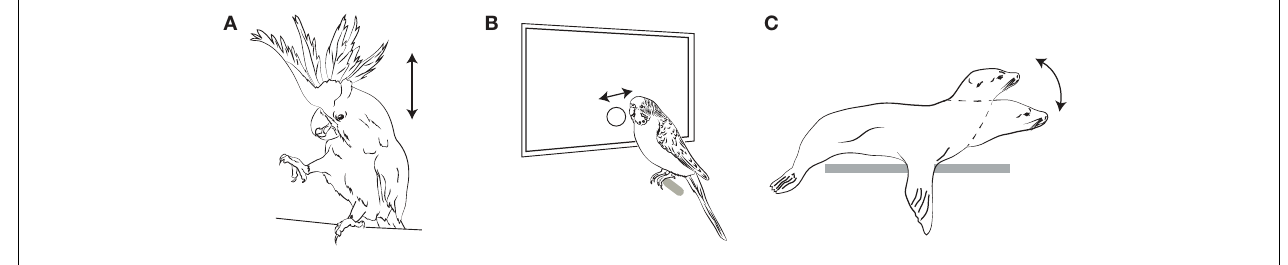
FIGURE 5 | Figures illustrating Pulse Perception and Synchronization as Recently Demonstrated in Three Non-human Species. (A) Sulfur-Crested Cockatoo ( Cacatua galerita ); (B) Budgerigar ( Melopsittacus undulatus ); (C)